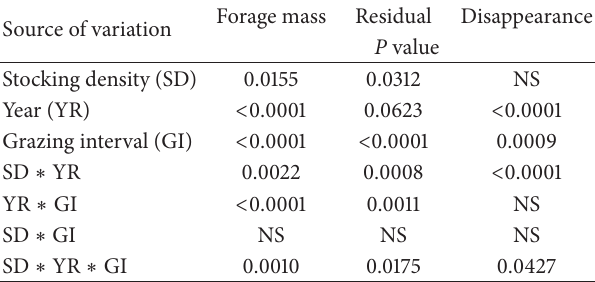
Table 4: Analysis of variance of forage mass, residual herbage, forage disappearance, and forage use as a function of stocking density, grazing interval, year, and their interactions. Forage mass Source of variation